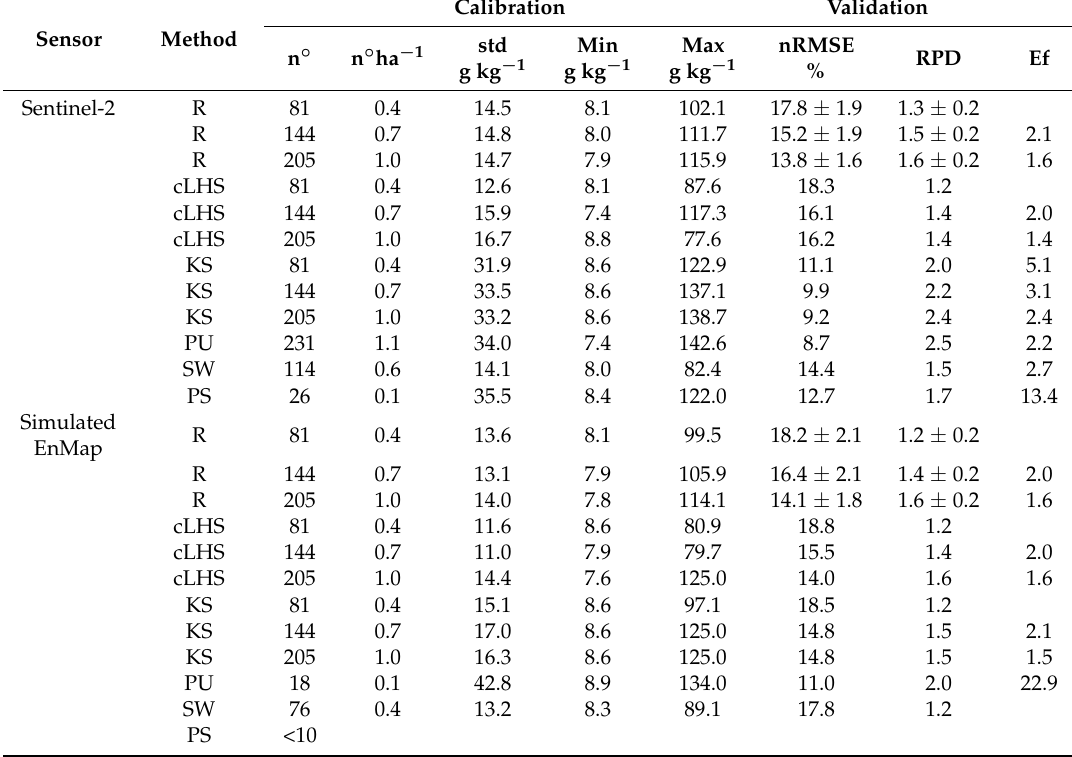
Table 2. Descriptive statistics of the SOC content of the calibration datasets detected by the sampling selection algorithms in the three fields, and the estimation accuracy in terms of normalized root mean square error (nRMSE), ratio of the performance to deviation (RPD) and efficiency index (Ef) obtained from the validation dataset (R = random sampling selection, cLHS = conditioned Latin Hypercube; KS = Kennard-Stones; PU = Puchwein; SW = SELECT; PS = Puchwein+SELECT). The average and standard deviation nRMSE and RPD values were reported for the random sampling